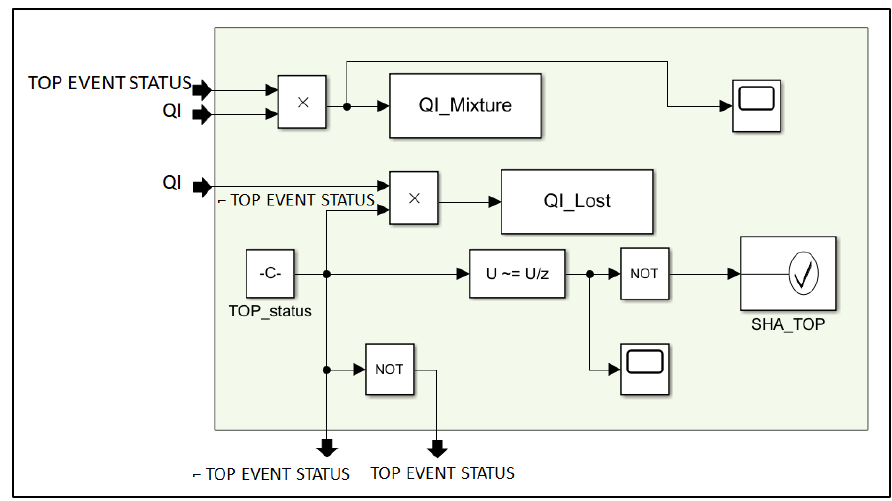
Figure 8. The Simulink implementation of the physical process of the case study.